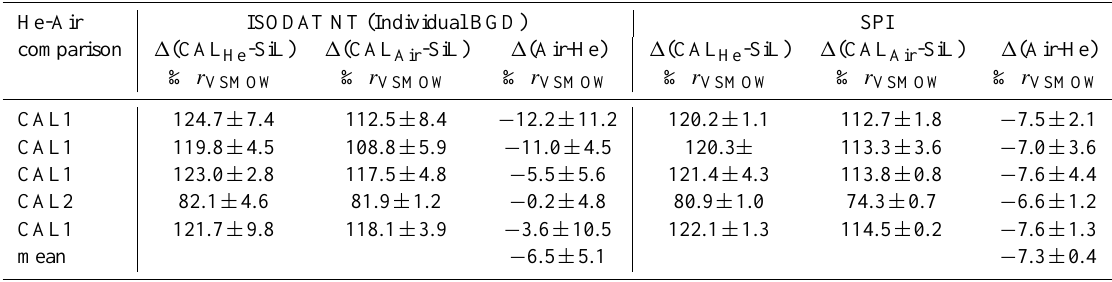
Table 3. Comparison of isotope reference gases diluted in He and air, respectively, with the two available evaluation methods. SPI signifi- cantly proves that He-diluted gases are measured heavier than air-diluted gases. He-Air ISODAT NT (Individual BGD) SPI comparison